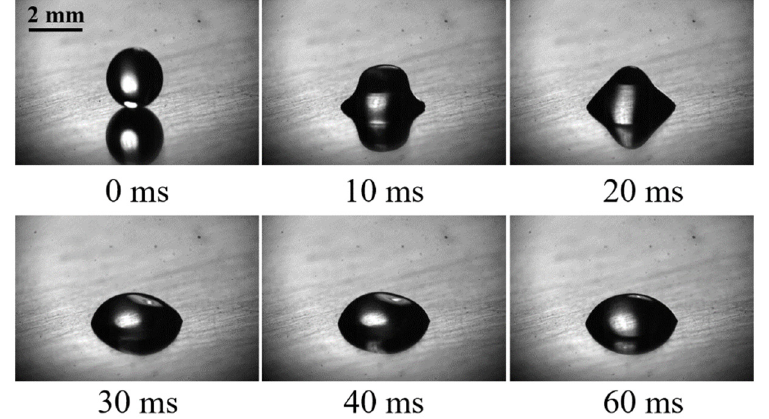
Figure 4. Droplet impact and spreading on the hydrophilic copper surface in different stages. Experimental conditions: W e = 7.6, T w = 40 °C.